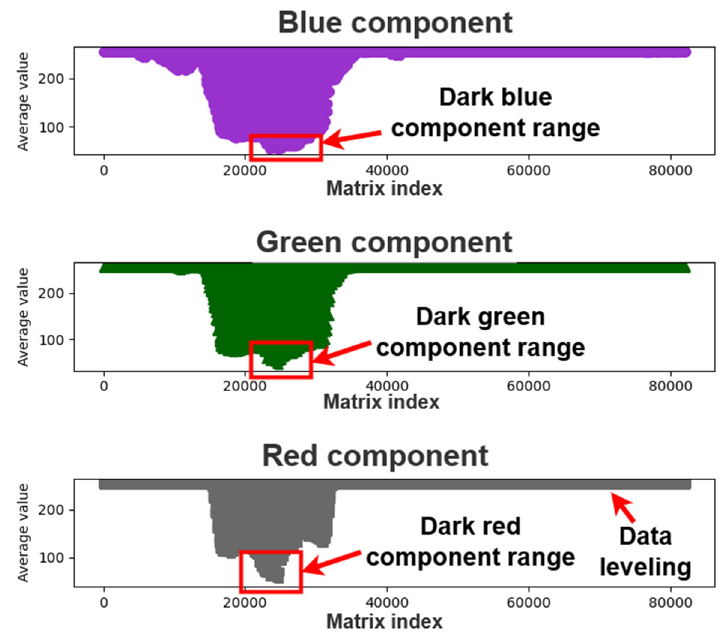
Figure 11. Dark component intervals for an image with enhanced exposure.